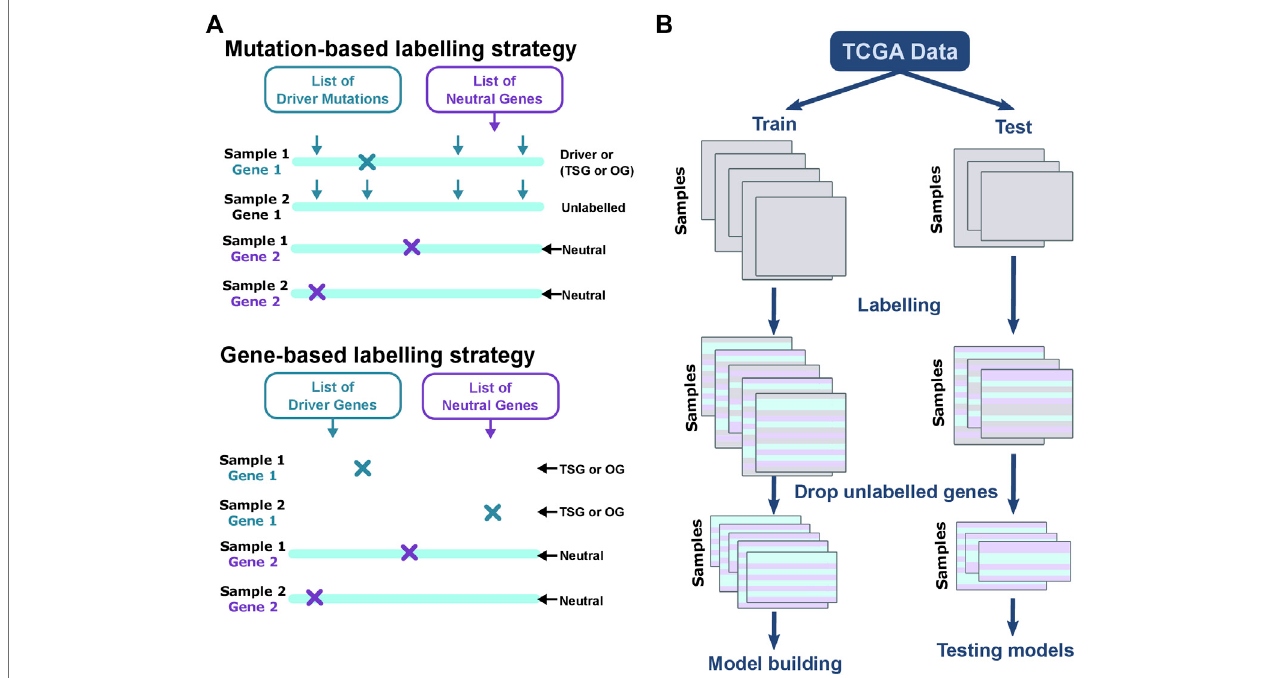
FIGURE 8 | Labeling data for training and testing. The fi gure explains the differences between labeling strategies and the steps for training and test split. (A) For mutation-based strategies, the gene and location of the mutation are both considered. The arrows indicate the locations of driver mutations in a gene. The mutation in Gene 1 coincides with known driver mutation and the gene is labeled as “ Driver ” in Sample 1. Mutation in Gene 1 of Sample 2 is not a known driver mutation. Since the mutationlocationsdifferbetweenthe fi rstandsecondsamplesshownhere,Gene1inSample2isunlabeled.Forgene-basedmethods,irrespectiveofthelocation ofmutation,Gene1islabeled “ Driver ” inSamples1and2.Alllistsofneutralgenesifalteredinasamplearelabeledasneutral.Gene-basedmethodscanbeusedtolabel mutation and CNV alterations. Altered genes, if present in the list of driver mutations or driver genes, are labeled as “ Driver ” if the labeling strategy is CIViC or “ TSG ” or “ OG ” fortherest. (B) Thesamplesaresplitintotrainingandtestintheratio70:30.Thenumberofmutationsmayvaryinsamples,andiscapturedbythevaryingshapesof thedataboxes.Eachrowrepresentsasample — genepairandthecolumnsrepresentthefeatures.Thegenesforeachsamplearelabeled,andusedforbuildingmodels and